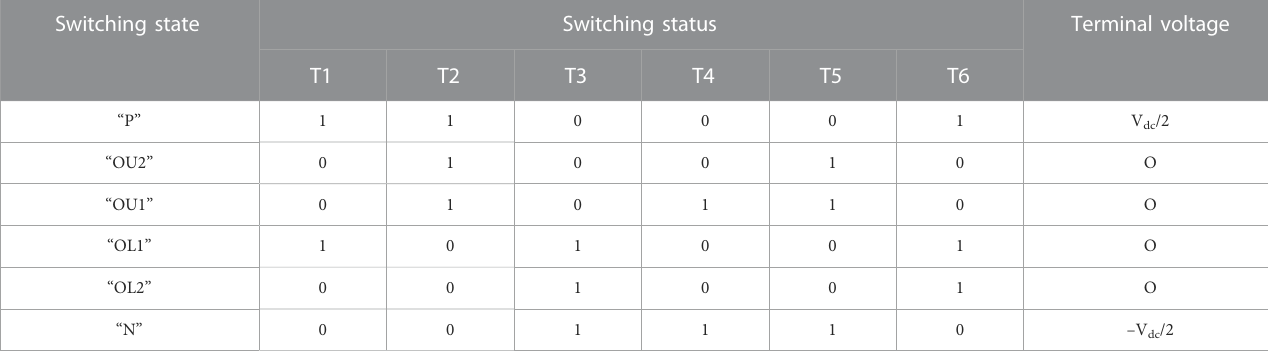
TABLE 1 Switching states of a 3L-ANPC inverter.